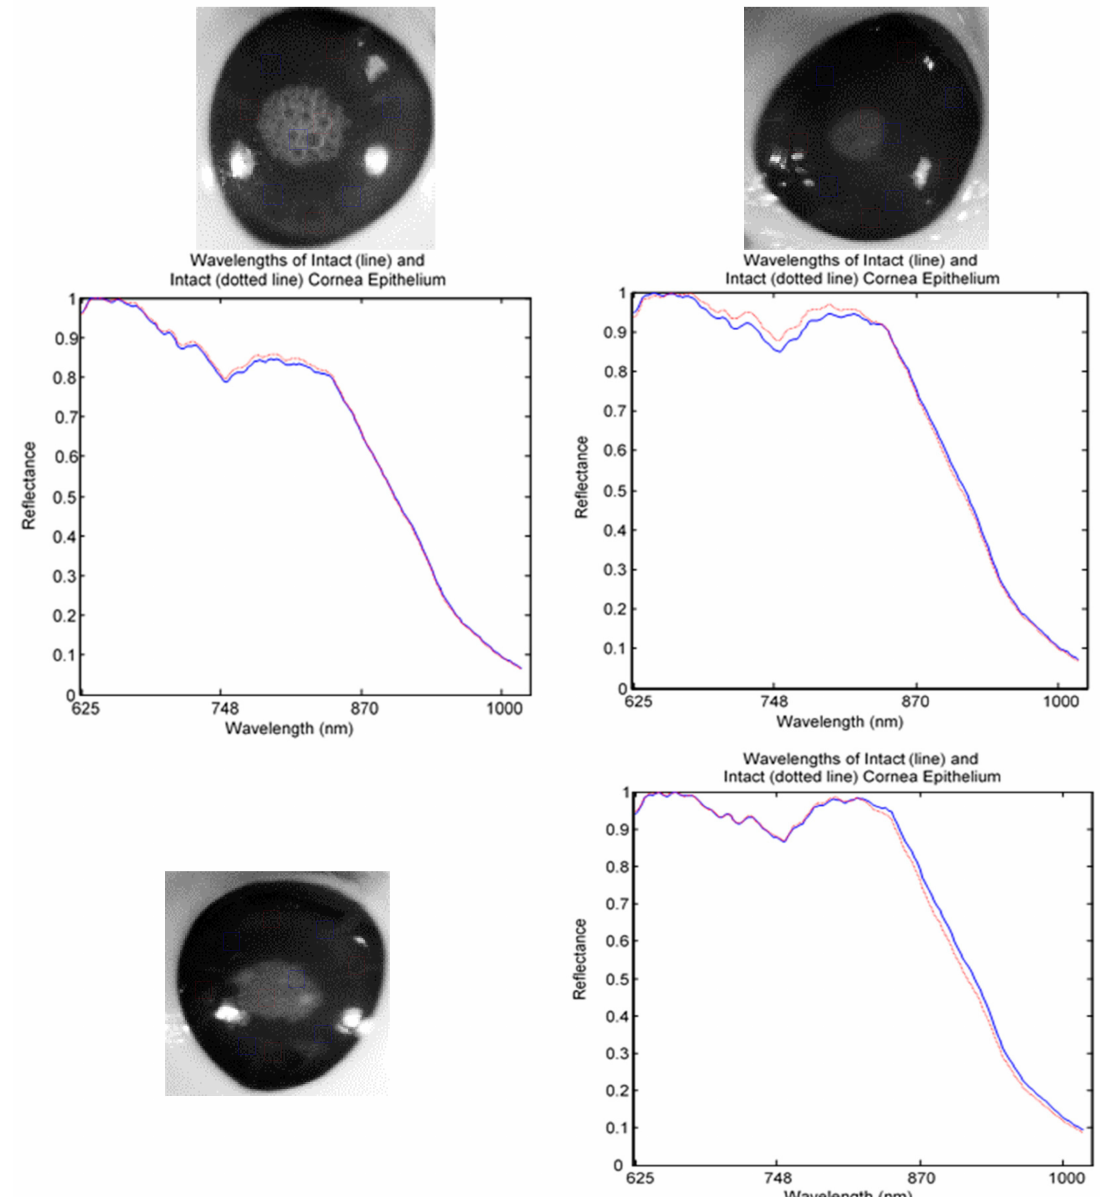
Figure 8. Reflectance signatures of healthy